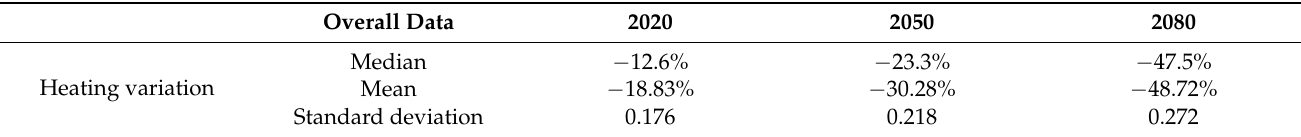
Table 5. Summary of synthetic descriptive indices related to the overall